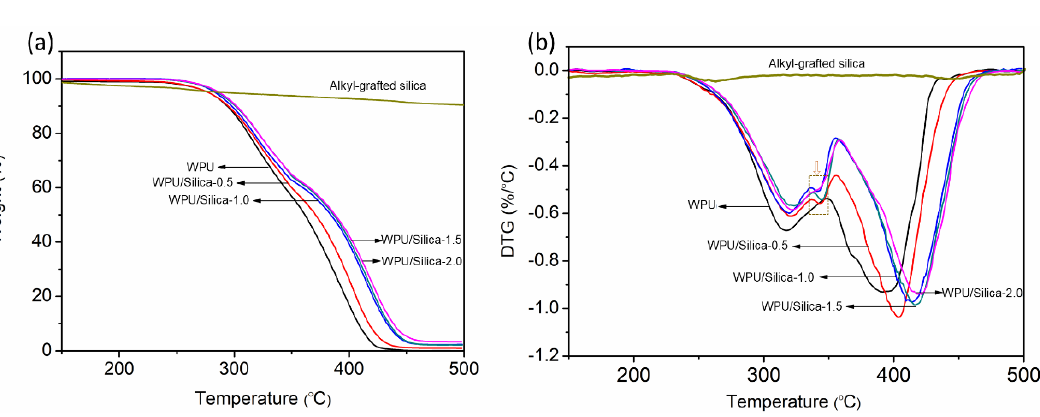
Figure 9. ( a ) TGA and ( b ) DTGA curves of alkyl-grafted silica, WPU, and WPU/Silica